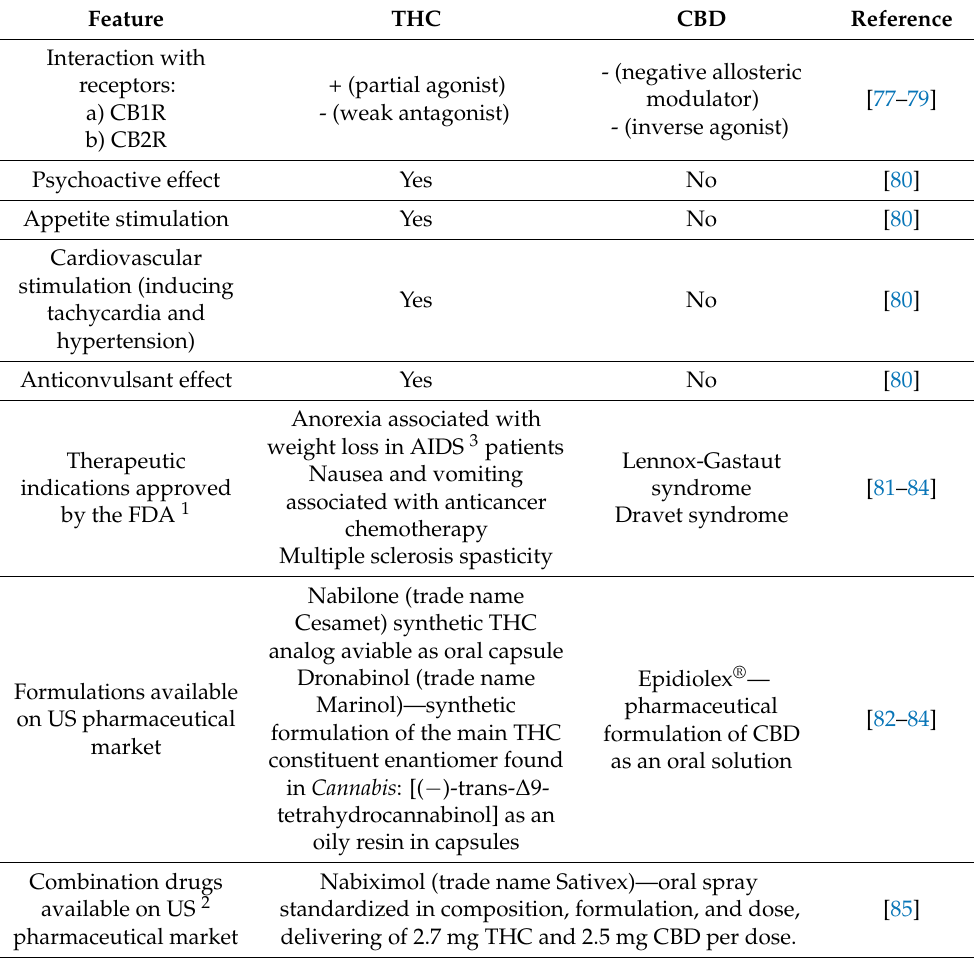
Table 1. Comparison of selected features of tetrahydrocannabinol (THC) versus cannabidiol